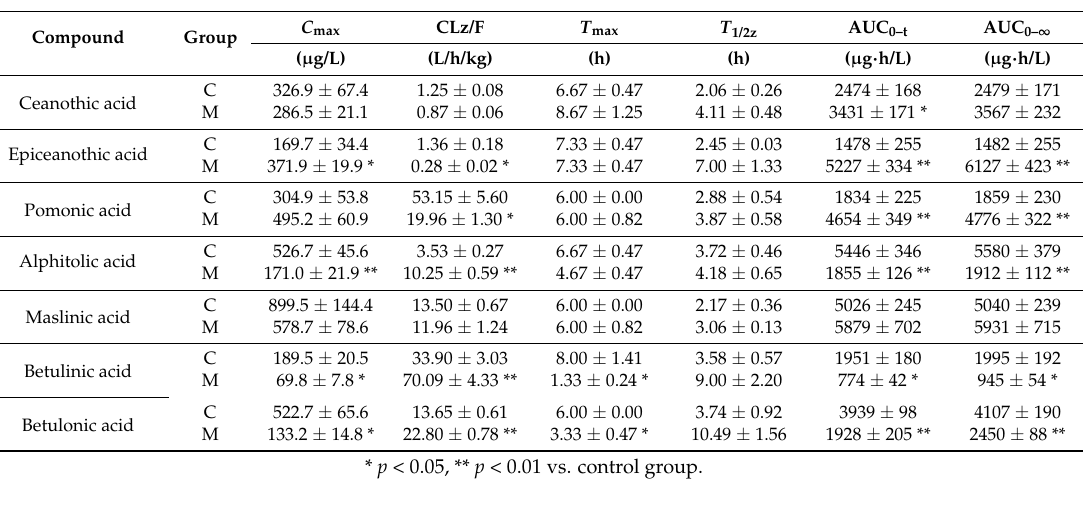
Table 5. Pharmacokinetic parameters of seven compounds after an oral administration in normal and model rats (means ± SEM, n = 6).